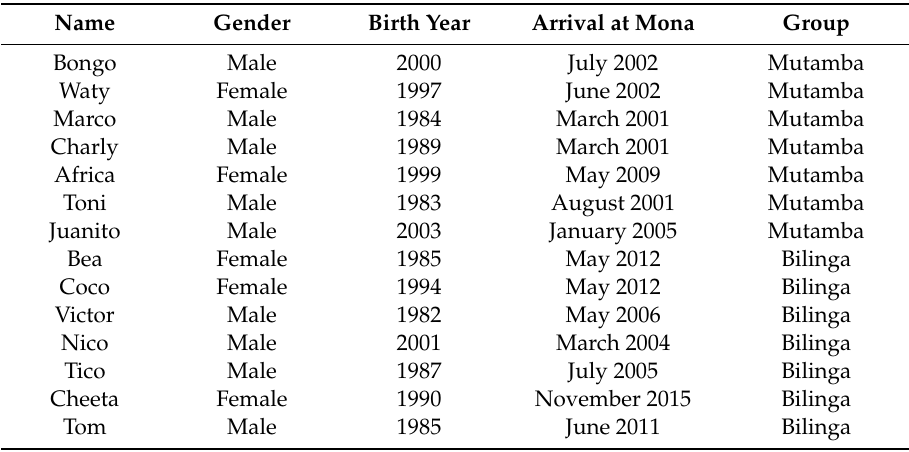
Table 1. List of biographical information on all chimpanzees housed at Fundaci ó